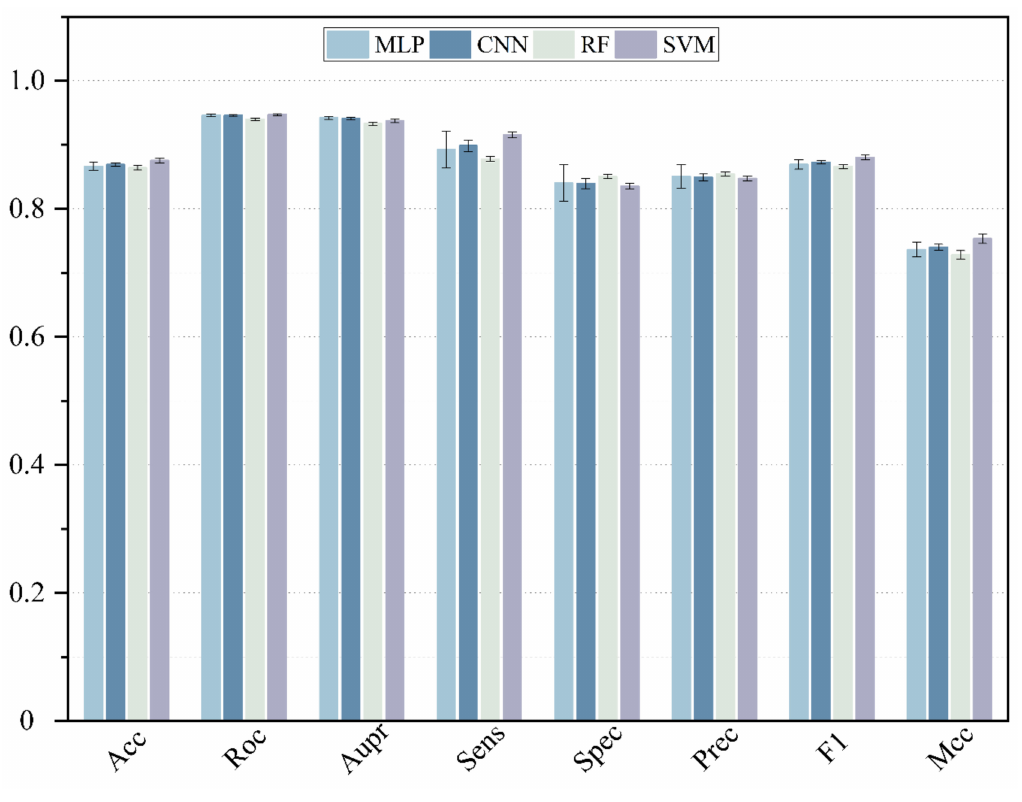
Figure 5. The performance comparison of different